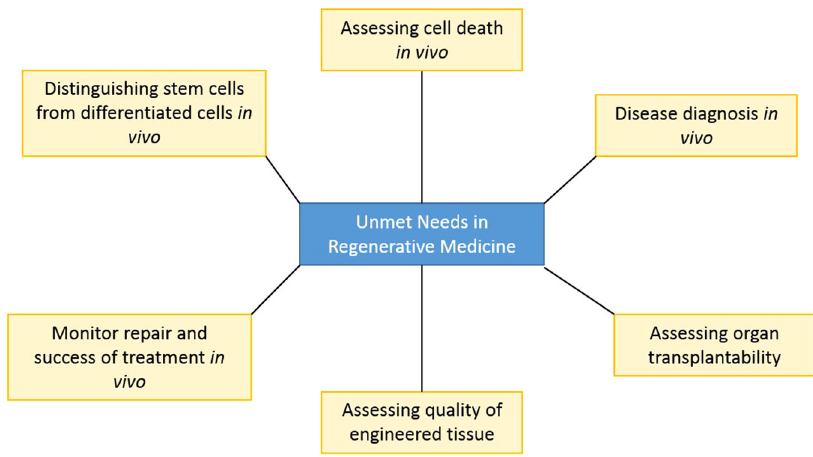
Fig. 6 Summary of some potential applications for Raman spectroscopy to the fi eld of regenerative